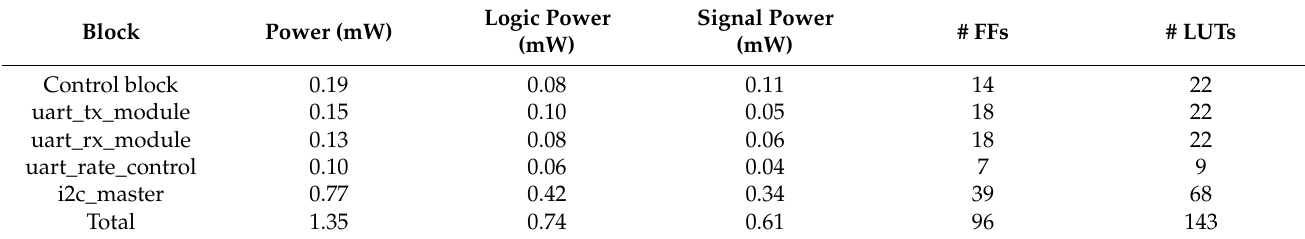
Table 4. Power consumption and FPGA resources used by I2C temperature sensing.